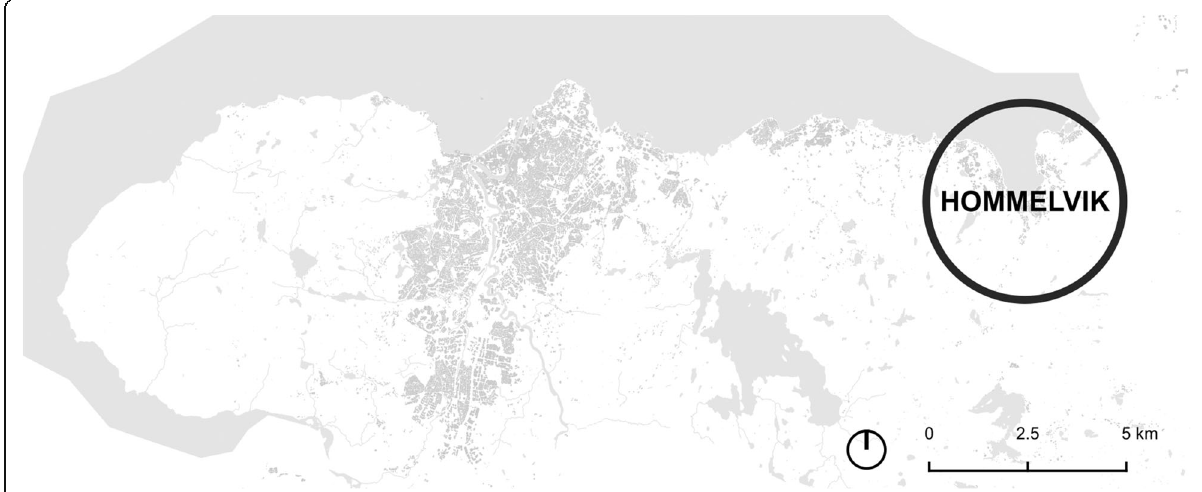
Fig. 1 The Trondheim region, with Hommelvik